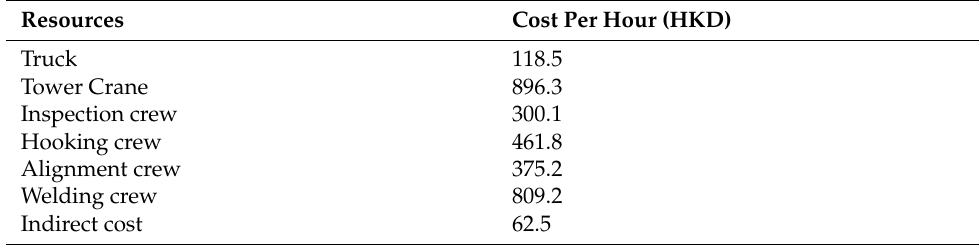
Table 4. Cost per hour in Hong Kong Dollars (HKD) for various